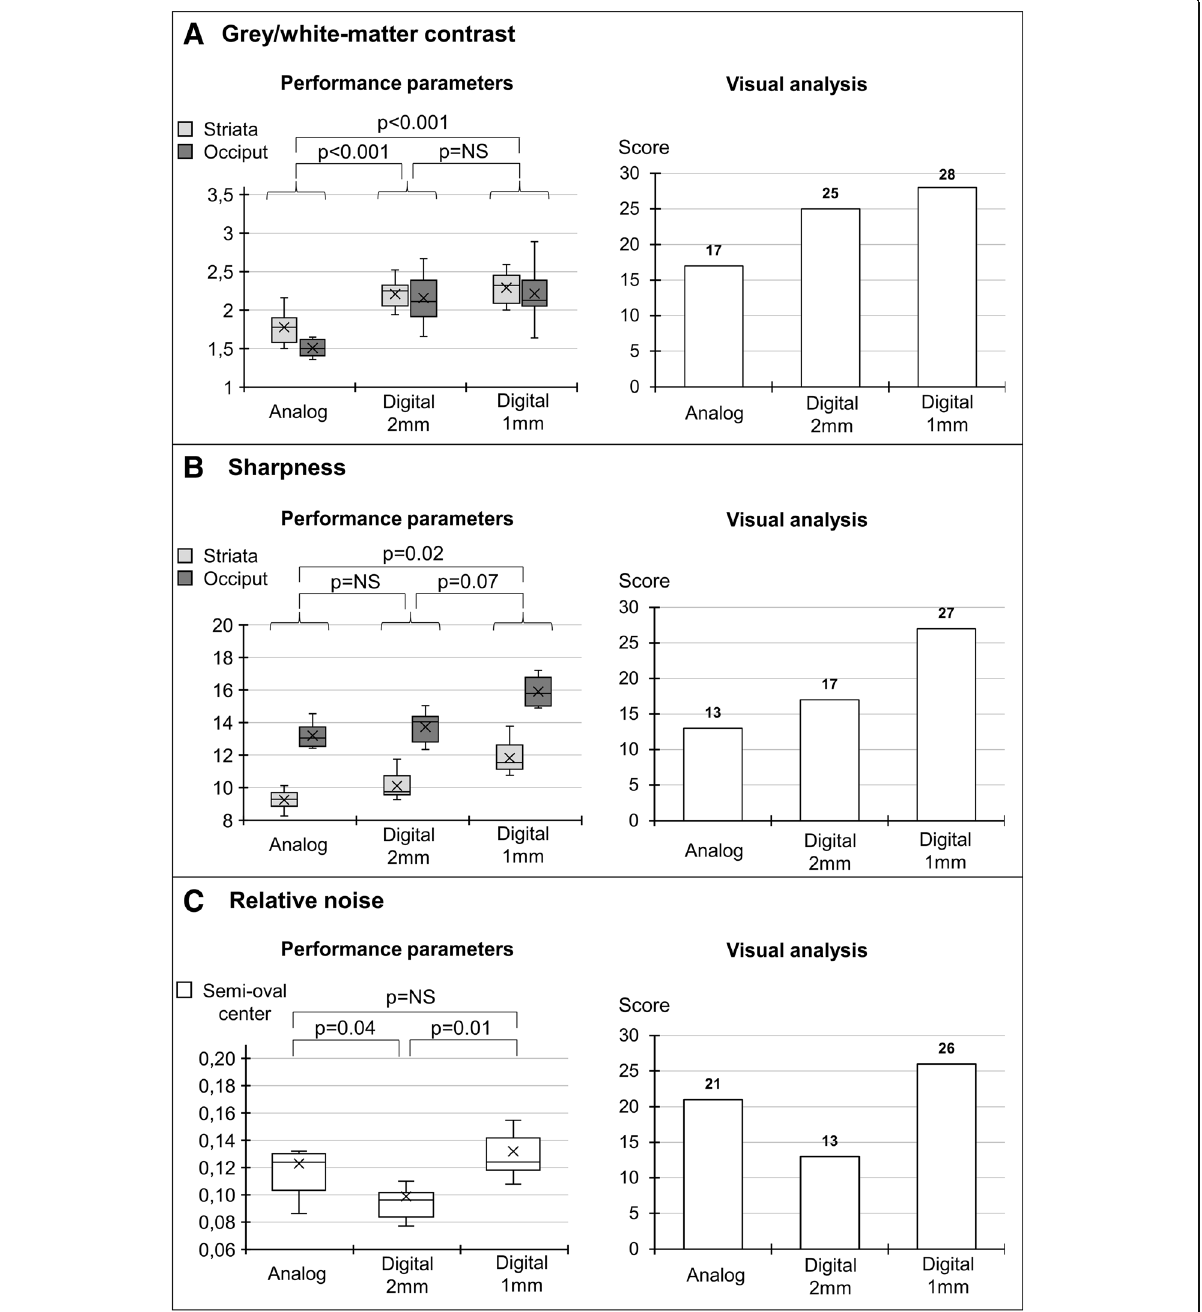
Fig. 3 Left panels: box-plots for a gray/white-matter contrast, b sharpness, and c relative noise index obtained with current 2-mm reconstruction processes of analog and digital PET images and with a 1-mm reconstruction process developed for digital PET images. Right panel: corresponding parameters provided by a visual analysis from experienced physicians (sum-scores for contrast, spatial resolution, and noise